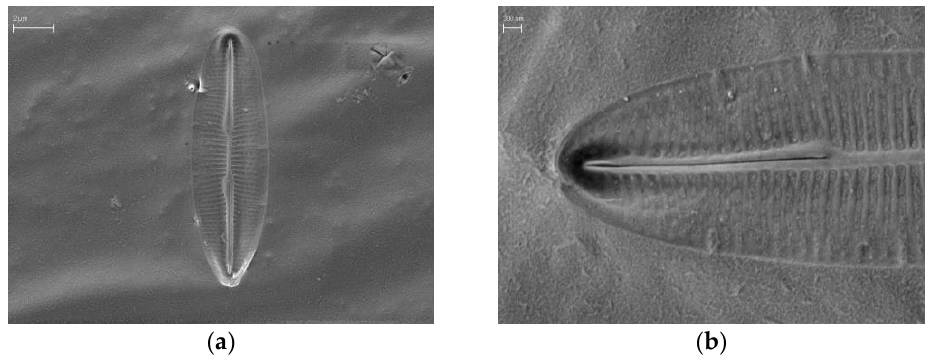
Figure 3. Berkeleya transfretana. Scanning electron microscopy (SEM). Individuals from the type population (valve views). ( a ) Whole valve, internal view; ( b ) detail of the apex, showing the striation pattern and one raphe branch.